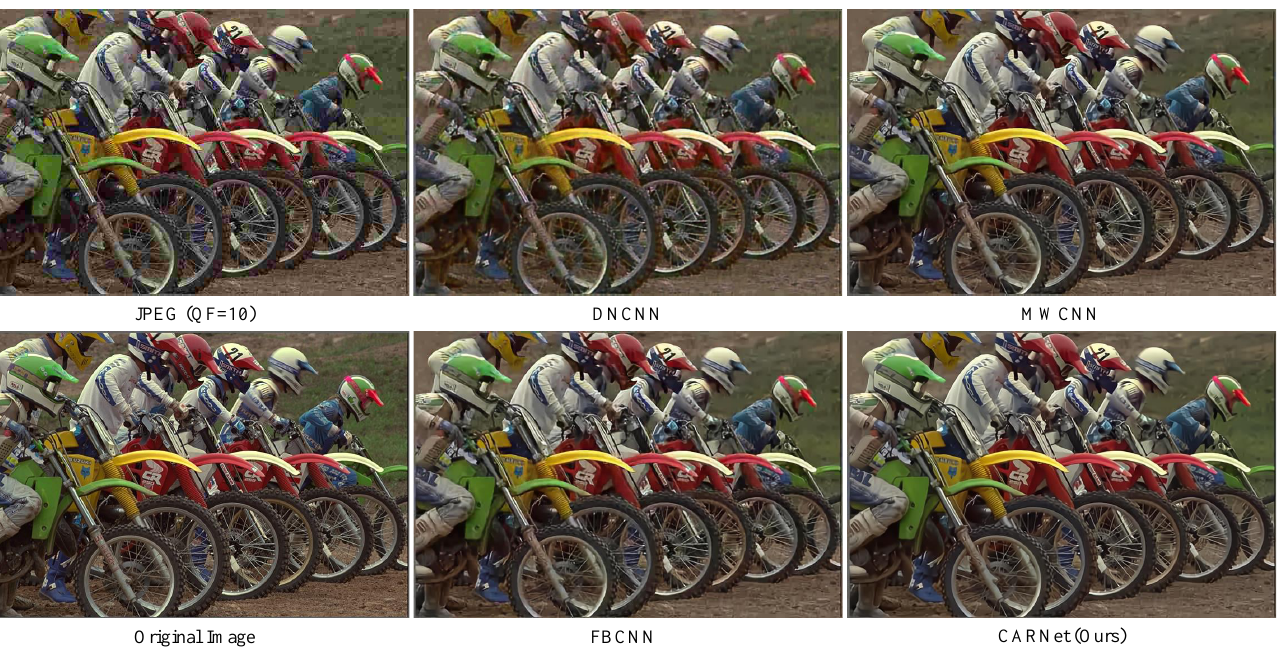
image patch (NEAR = 8), Figure S2. Visual comparison with state-of-the-art methods on a test 12 bit image patch (NEAR = 12), Figure S3. Visual comparison with state-of-the-art methods on a test 12 bit image patch (NEAR =